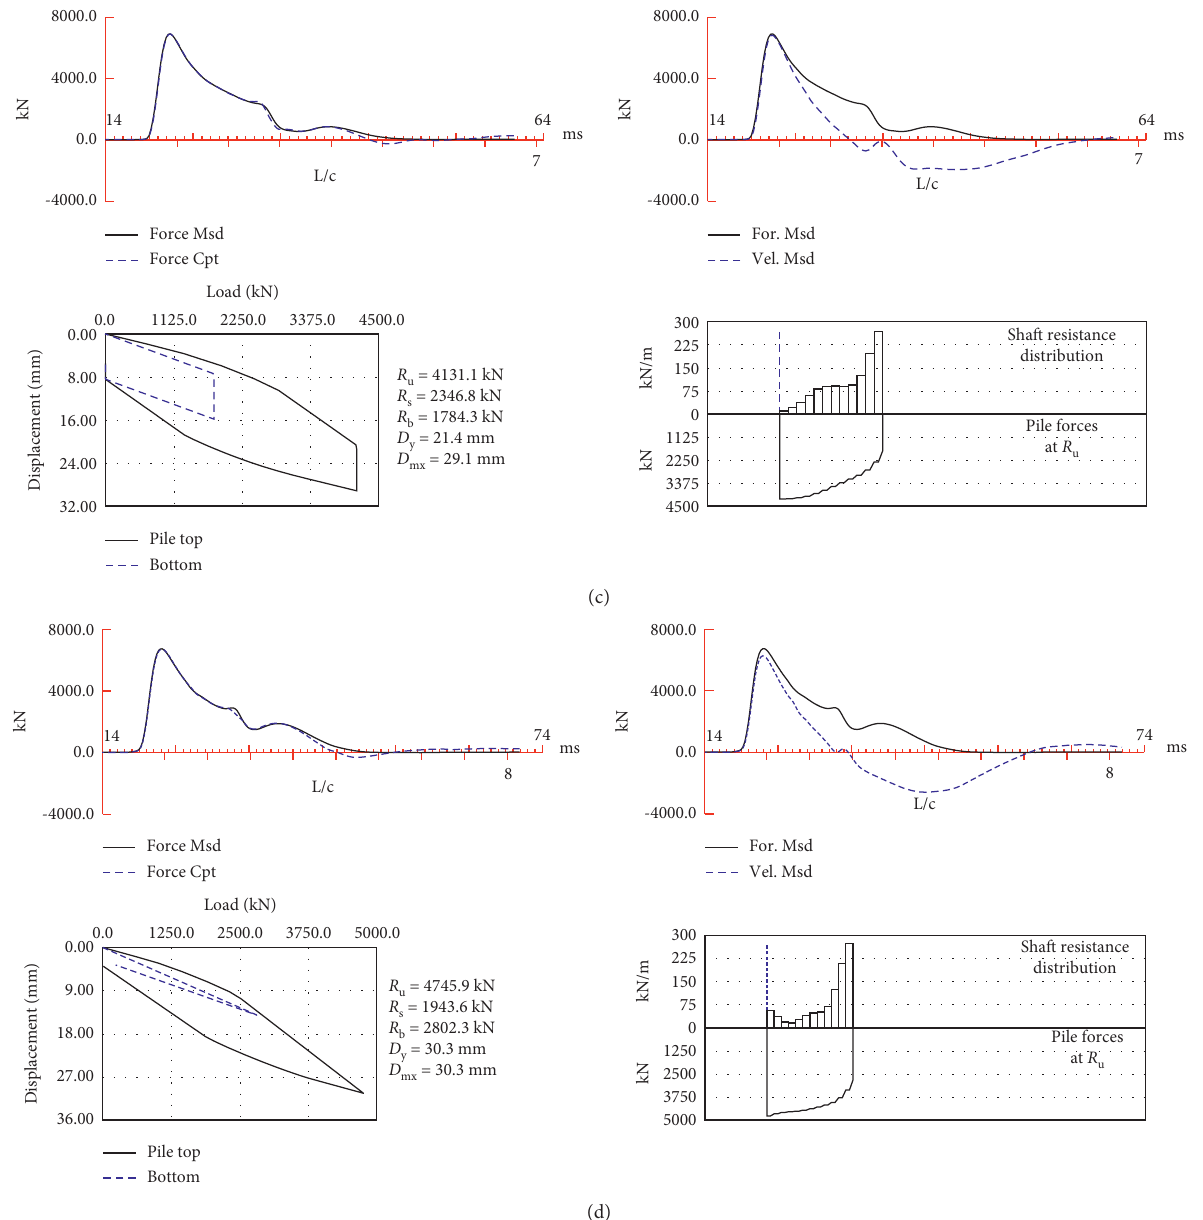
Figure 10: Results of high-strain curve fitting for test piles (at the hard rock bearing stratum site). (a) Pile #7. (b) Pile #8. (c) Pile #10. (d) Pile